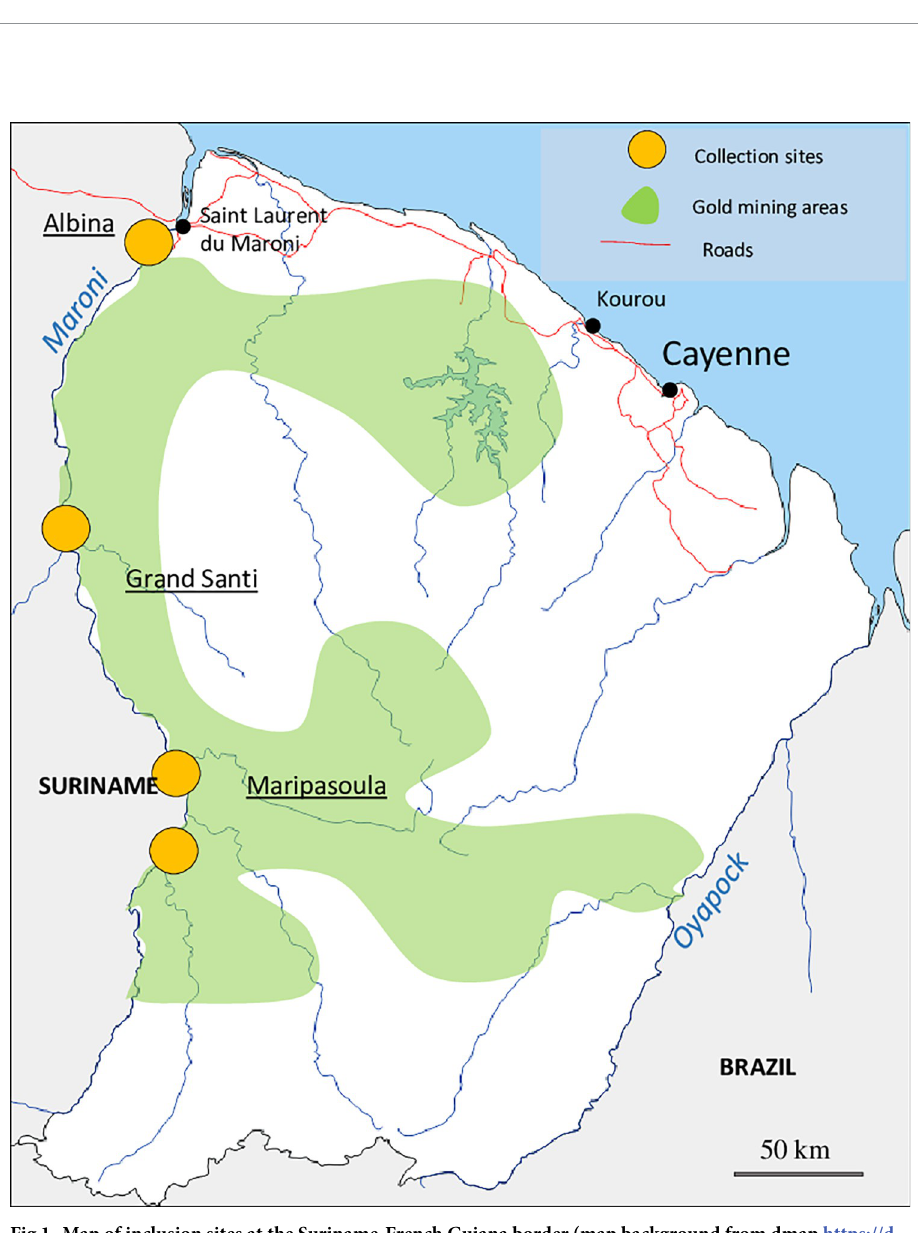
Fig 1. Map of inclusion sites at the Suriname-French Guiana border (map background from dmap https://d-